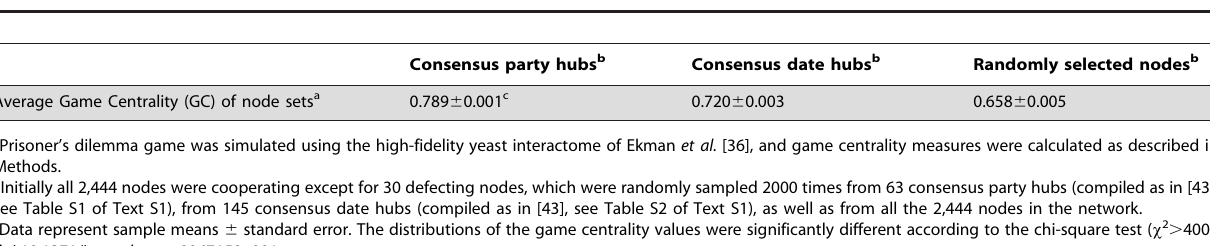
Table 1. Game centrality of party hubs, date hubs and randomly selected nodes of a high-fidelity yeast protein-protein interaction network.